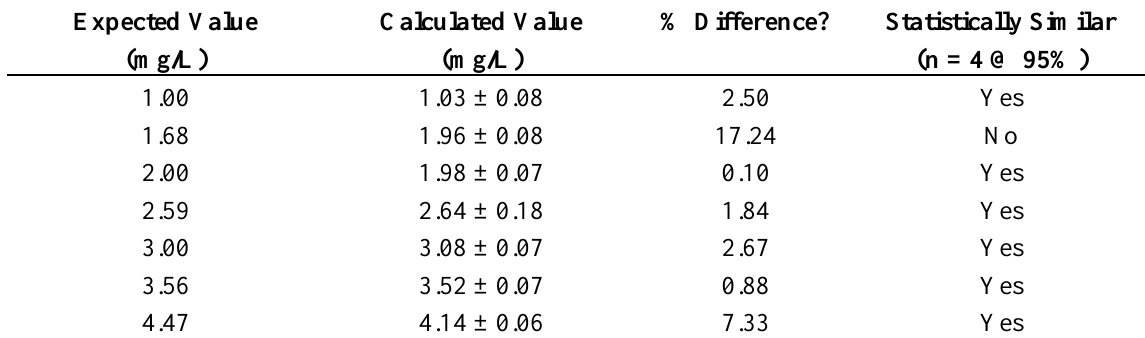
Table 2. A summary of the copper concentrations determined using Equation (1) with a comparison against the expected value. The Student’s t-test was used to determine statistical